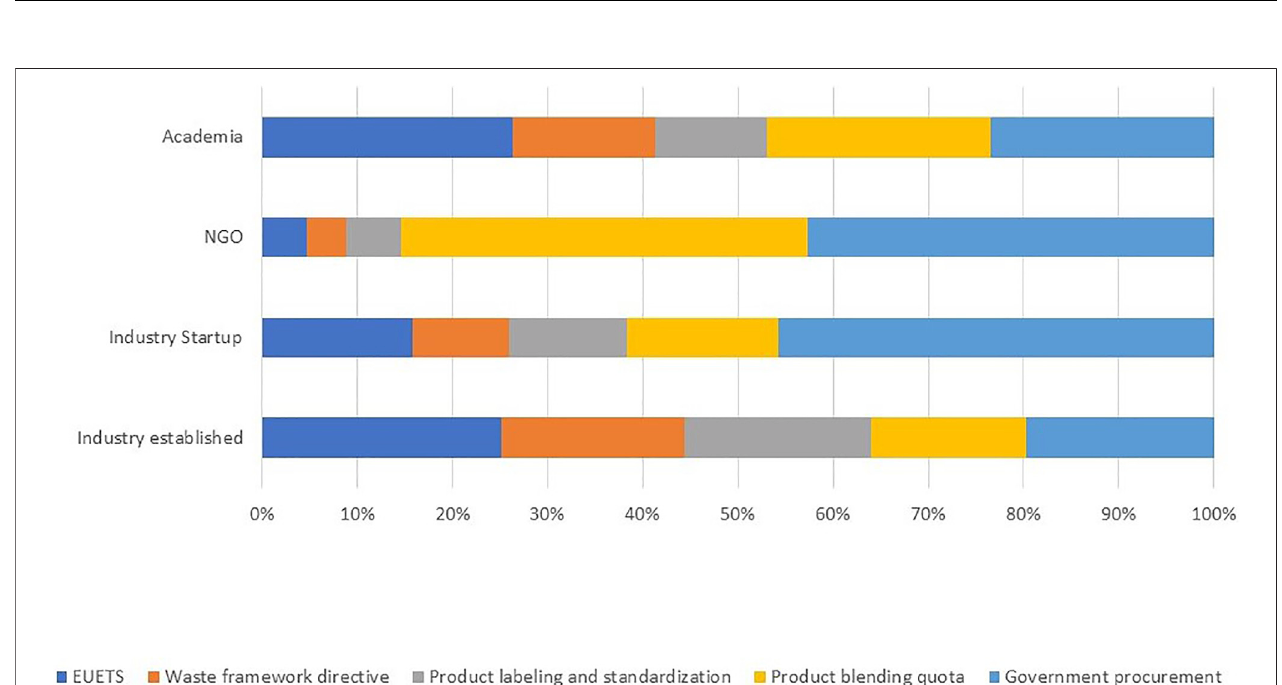
FIGURE 3 | Prioritization of policy options: individual responses (n (cid:1)